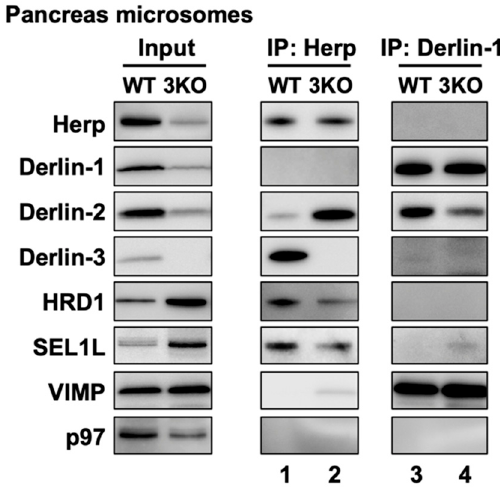
Figure 7. Effects of Derlin-3 deficiency on the mouse pancreas ERAD complex formation. WT and 3KO mice were fasted for 12 h before euthanasia. Pancreas were homogenized and subjected to subcellular fractionation using centrifugation. Digitonin-solubilized pancreas microsomes were prepared, and coimmunoprecipitation was performed using Herp and Derlin-1 antibodies. The input and eluates were analyzed by Western blotting using antibodies indicated on the left side.